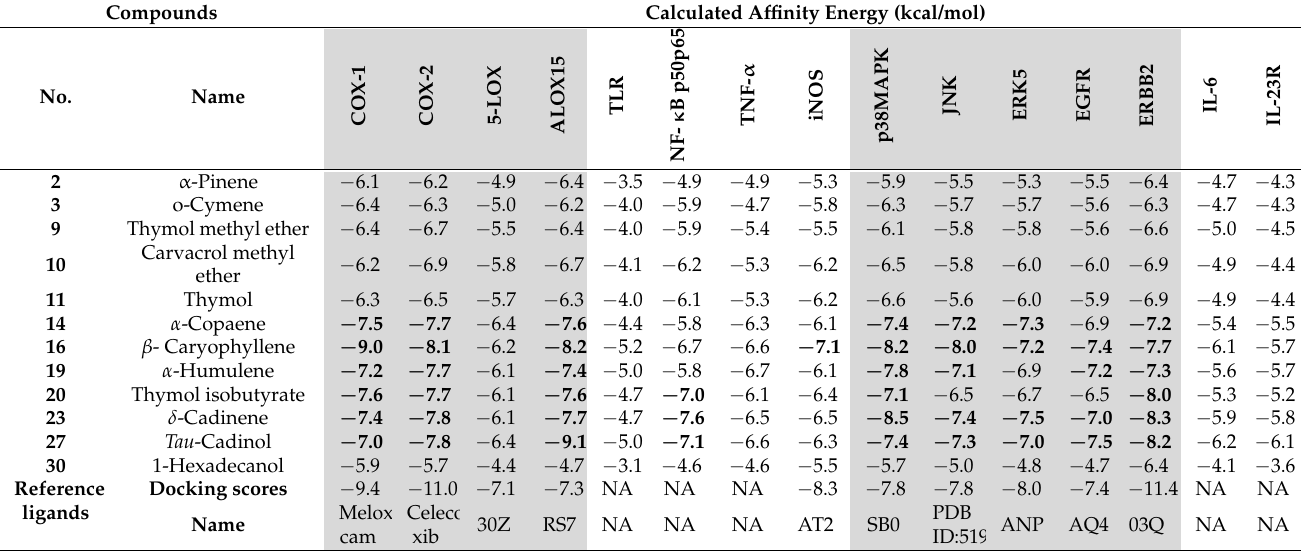
Table 2. Docking energy of the 12 main compounds with target